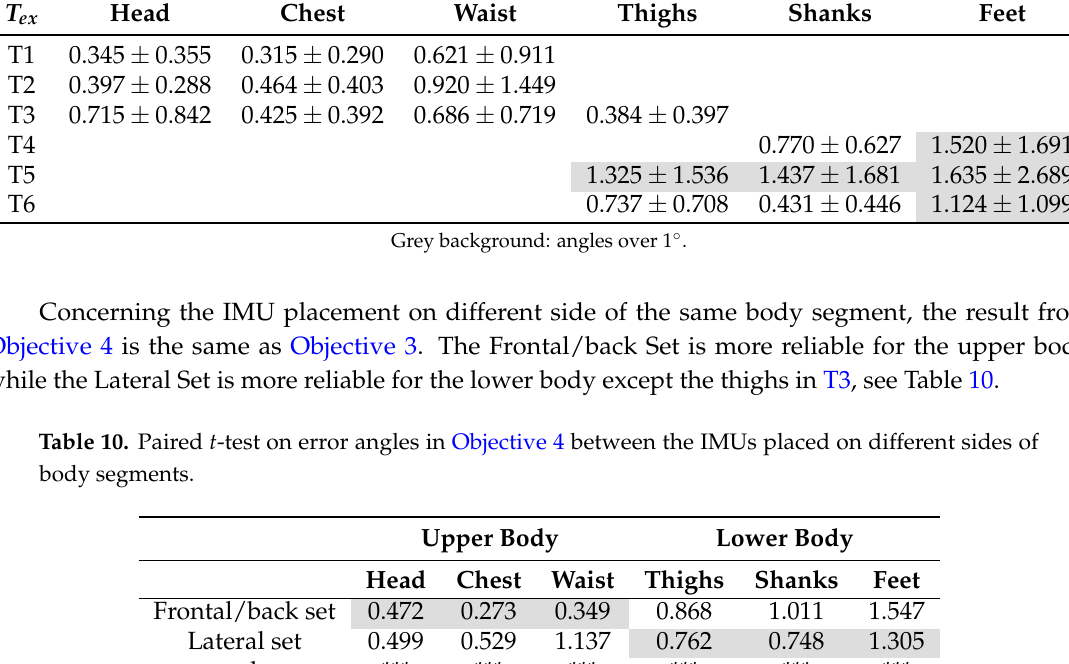
Table 9. Error angle (unit: degree), when using different subsets of three repetitions from the same test. Upper Body Lower Body T ex